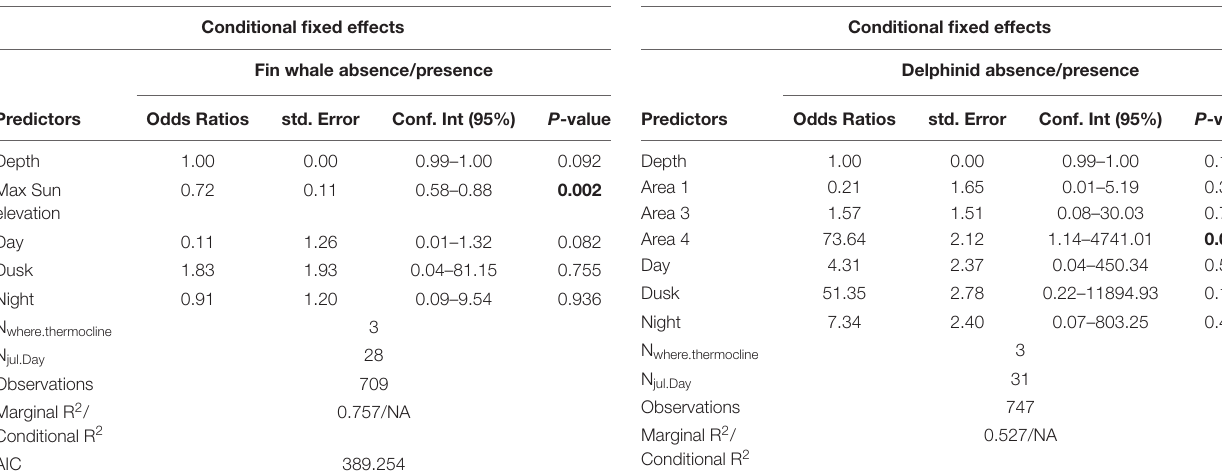
TABLE 5 | Model output for